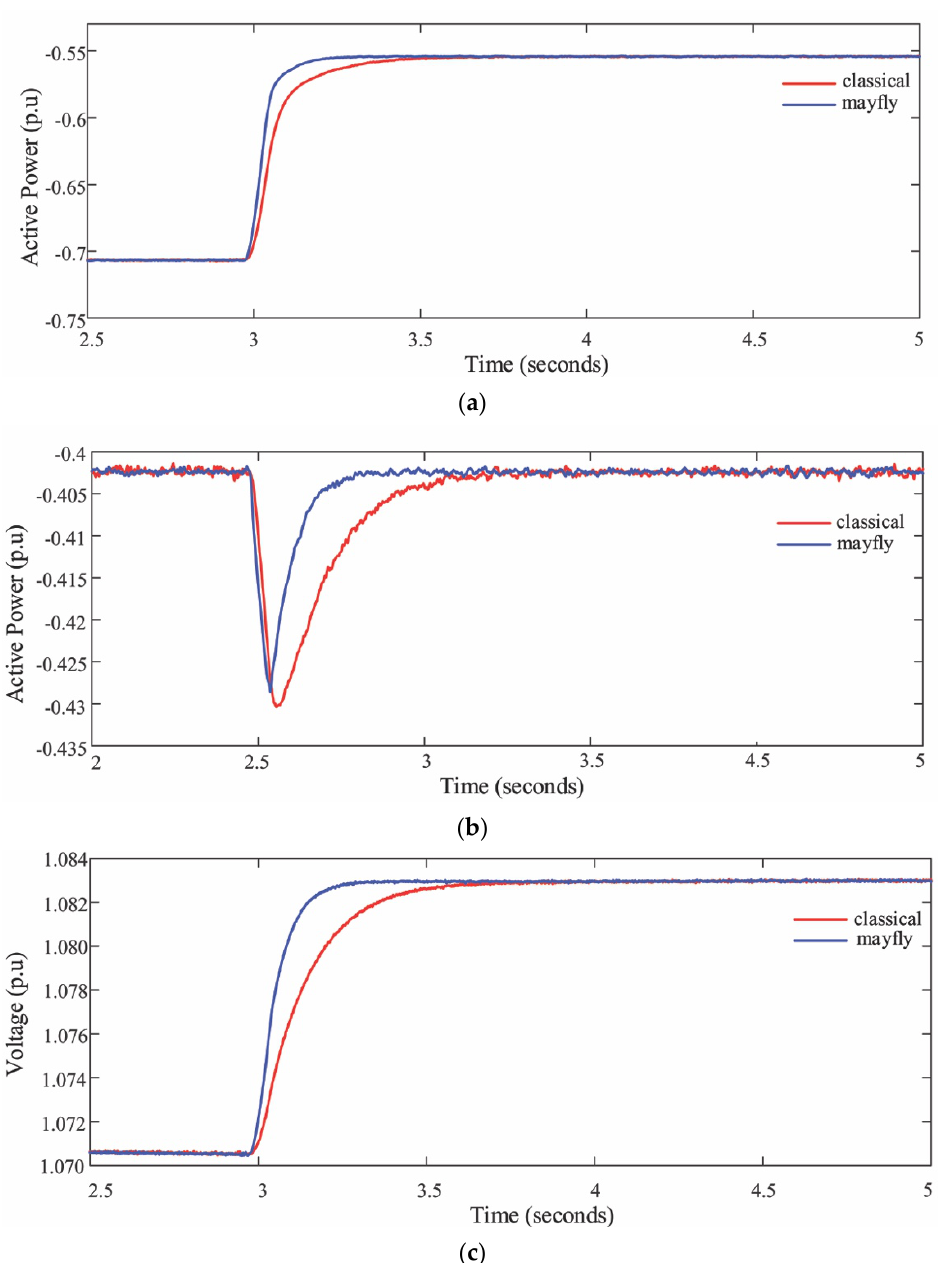
Figure 15. Power and voltage profiles at grid side 1 and grid side 2; ( a ) the power change at grid side 1; ( b ) the power change at grid side 2; ( c ) the change at DC-link voltage due to grid side 1.